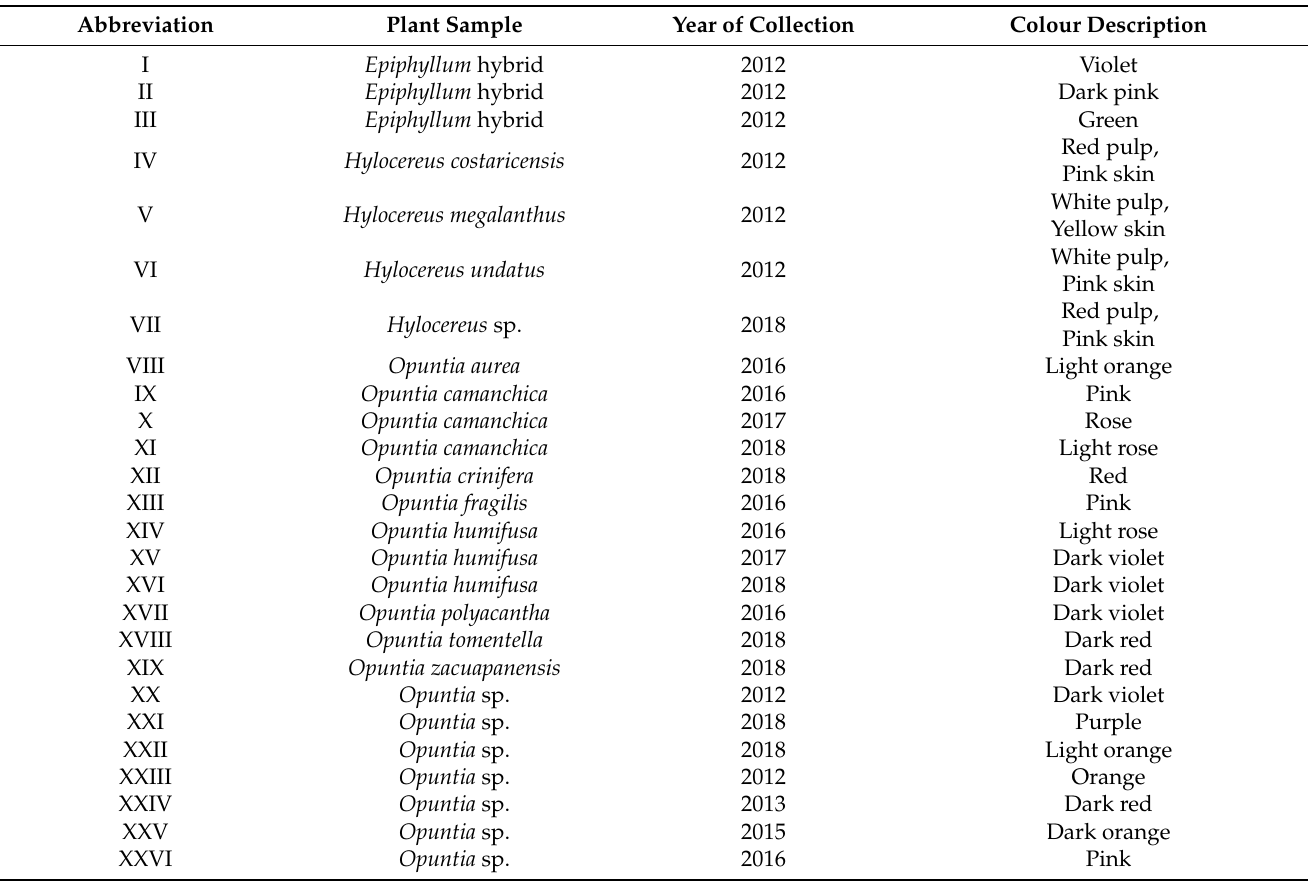
Table 7. List of Epiphyllum , Hylocereus , and Opuntia fruit